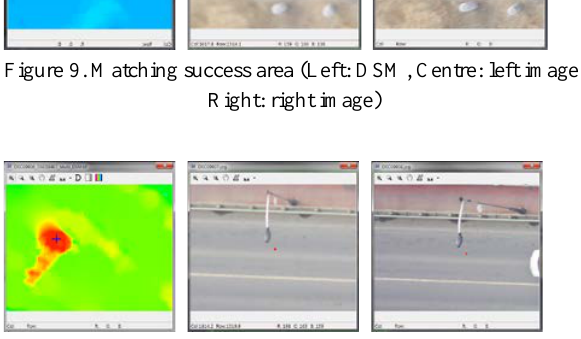
Figure 10. The blunder due to structure (Left: DSM, Centre: left image, Right: right image)